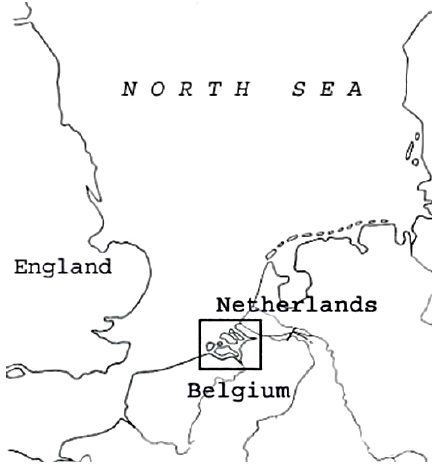
Figure 1. The former archipelago of the mouths of River Western Scheldt, Eastern Scheldt and River Meuse. The study area in the box consists of the Dutch provinces of Zeeland, the western part of North Brabant and the area south of